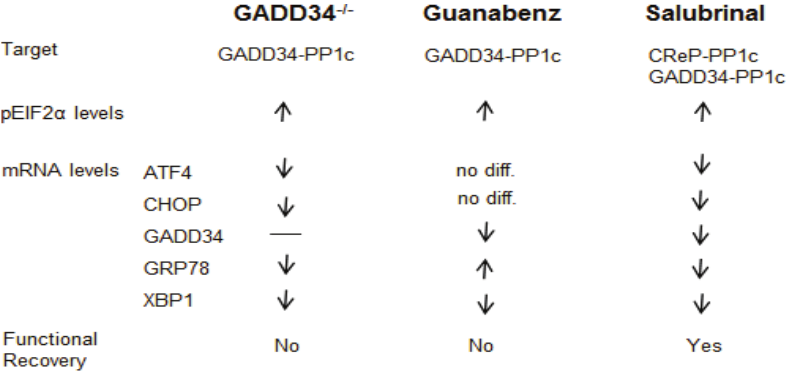
Figure 8. Schematic diagram showing the transcriptional and translational comparison and differences between the GADD34 -/- , guanabenz- and salubrinal- treated